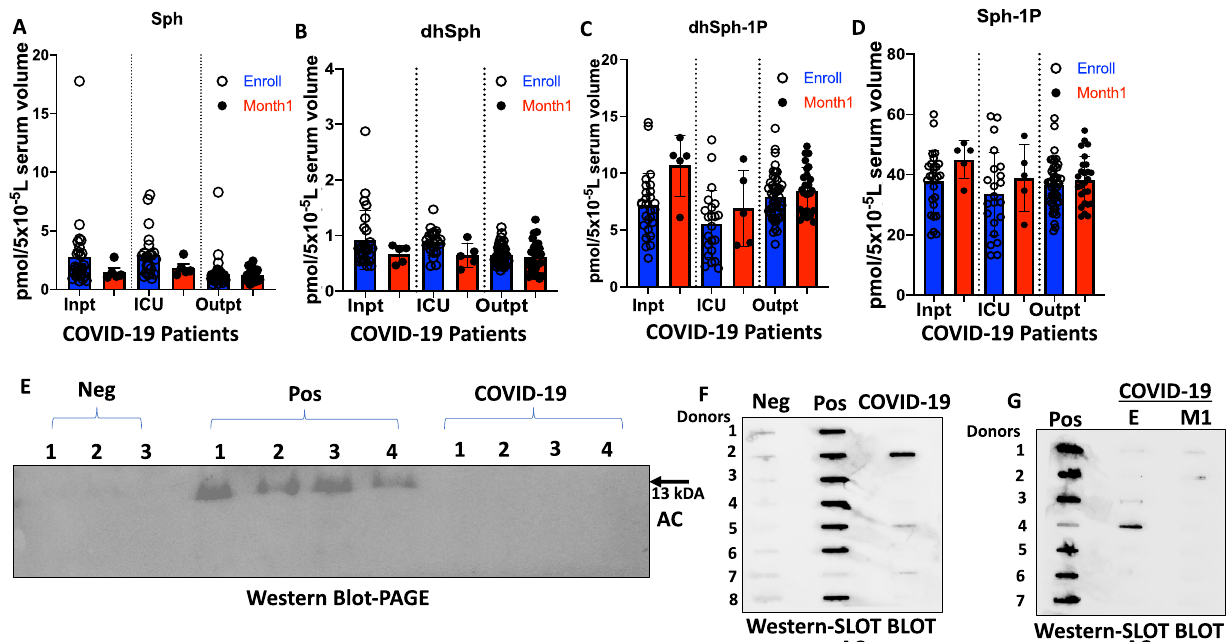
Figure 4. Elevated acid ceramidase level in asymptomatic serum is positively correlated with sphingosine levels. LC–MS/MS measurements for ( A ) sphingosine (Sph), ( B ) dihydro-sphingosine (dhSph), ( C ) dihydro- sphingosine 1-phosphate (dhSph-1p), and ( D ) sphingosine 1-phosphate (Sph-1p). ( E ) Representative western blot image detecting AC (mature alpha-subunit) in equal volumes (24 µl) of serum for Neg (n = 18), Pos (n = 22), and COVID-19 (n = 22). Representative slot blot images detecting AC in equal volumes (15 µl) of serum for ( F ) Neg (n = 23), Pos (n = 114), and COVID-19 (n = 23), and ( G ) Pos (n = 59), E (n = 59), and M1 (n = 59). Inpt inpatient (E, n = 27; M1, n = 5), ICU Intensive Care Unit (E, n = 22; M1, n = 5); Outpt outpatient (E, n = 46; M1, n = 26). Pos asymptomatic positive antibody test, E enrolled at time of diagnosis, M1 one month of recovery, Neg negative antibody test, COVID-19 symptomatic patients. Data are means of ± SEM, and P < 0.05 is considered